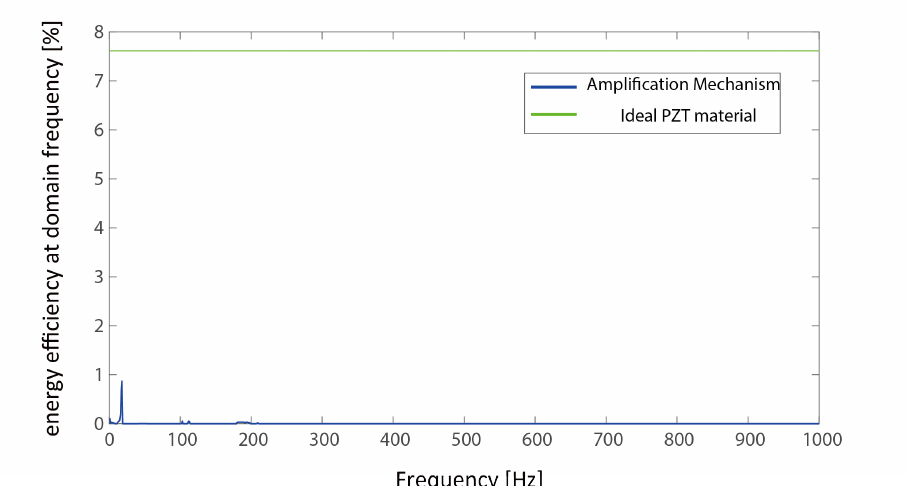
Figure 13. Efficiency of output power transfer versus frequency, with ideal PZT bender efficiency for